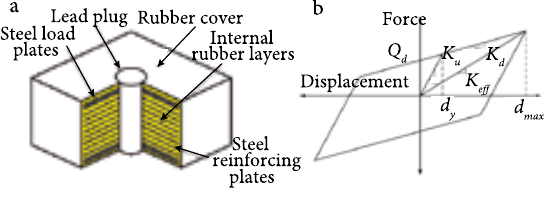
Fig. 2. Formation (a) and analysis model and theoretical hysteresis curve (b) of the